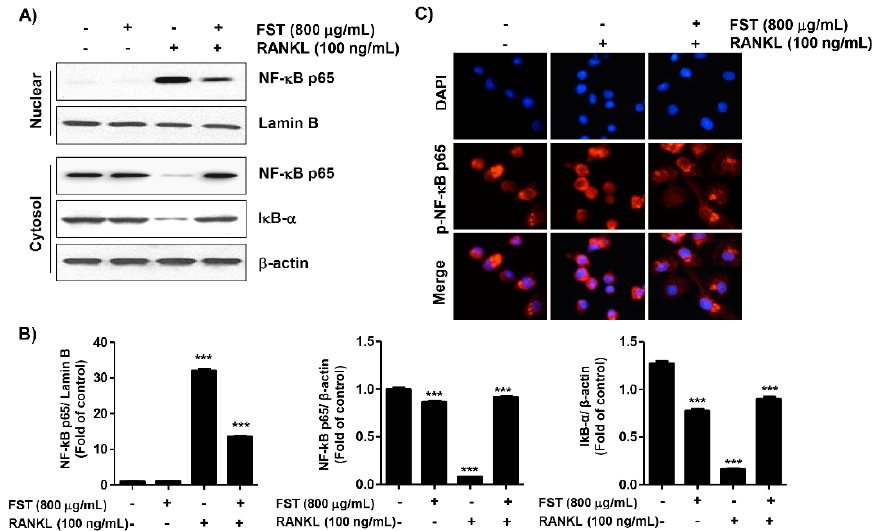
Figure 4. Effects of FST on the RANKL-induced activation of NF- κ B in RAW 264.7 mouse macrophage-like cells. ( A ) After co-treating cells with 100 ng / mL RANKL in the presence or absence of FST for 1 h, nuclear and cytosolic proteins were isolated. The expression of NF- κ B and I κ B- α were determined by Western blotting. Lamin B and β -actin were used as internal controls for the nuclear and cytosolic fractions, respectively. ( B ) Densitometry quantifications of protein expressions were measured by ImageJ. Statistical analyses were conducted using analysis of variances between groups. *** p < 0.0001 when compared to control. ( C ) Cells grown on gelatin-coated glass coverslips were co-treated with 800 µ g / mL FST with or without 100 ng / mL RANKL. Localization of phospho-NF- κ B p65 was observed under a fluorescence microscope following staining with anti-phospho-NF- κ B p65 antibody (red) and DAPI (nuclear stain; blue). Original magnification × 400. RANKL: receptor of activator of nuclear factor kappa-B ligand; FST: fermented sea tangle extract; I κ B α : inhibitory proteins of kappa B, alpha; NF- κ B: nuclear factor-kappa B; + : cells treated the reagent; -: cells untreated the